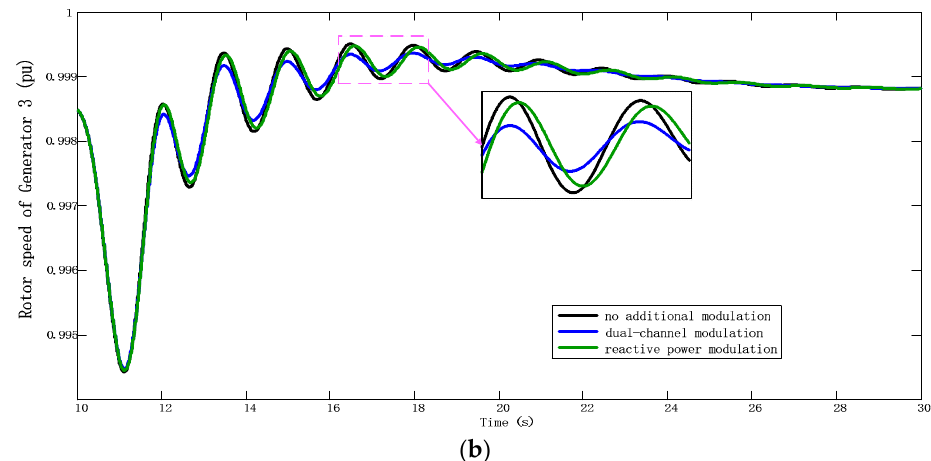
Figure 11. ( a ) Rotor speed of Generator 3 at Case A; ( b ) Rotor speed of Generator 3 at Case B.